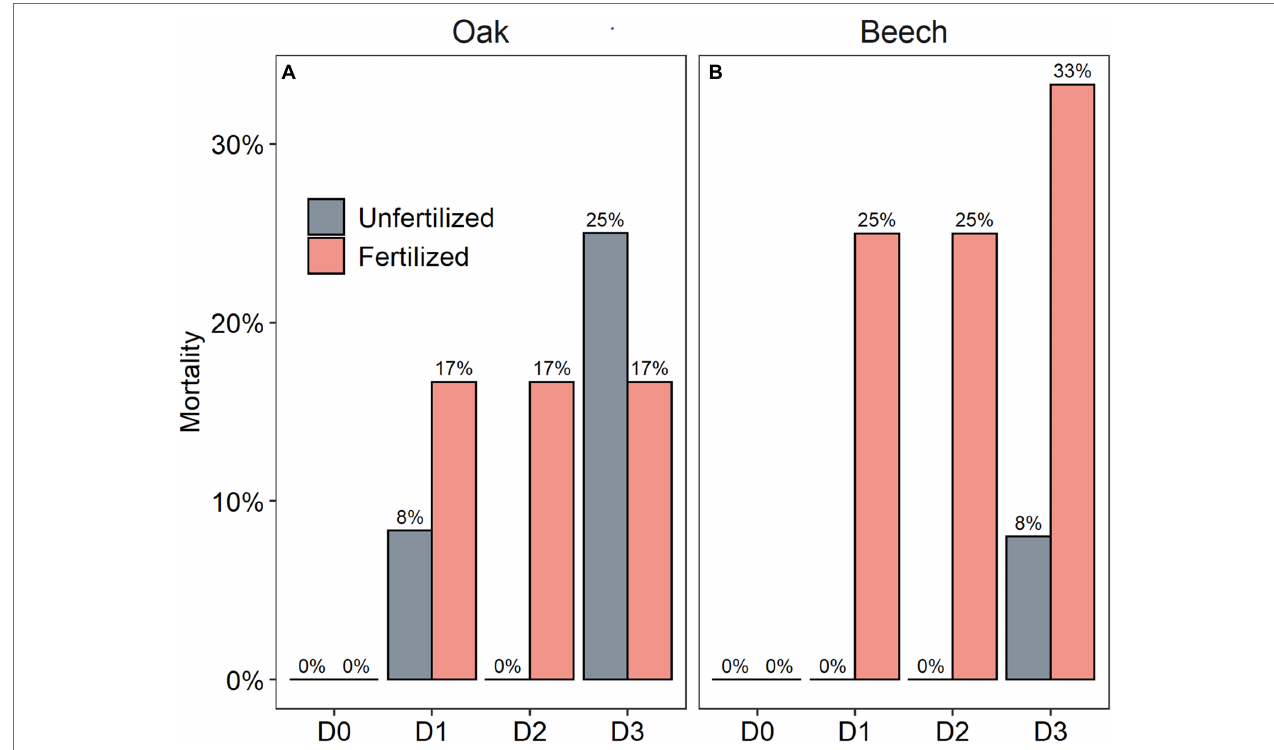
FIGURE 6 | Mortality rate of oak ( Quercus petraea ) (A) and beech ( Fagus sylvatica ) (B) saplings at the end of a recovery growing season following a growing season with four drought duration treatment (D0 = watering weekly, D1 = watering biweekly, D2 = watering monthly, and D3 = watering bimonthly) combined